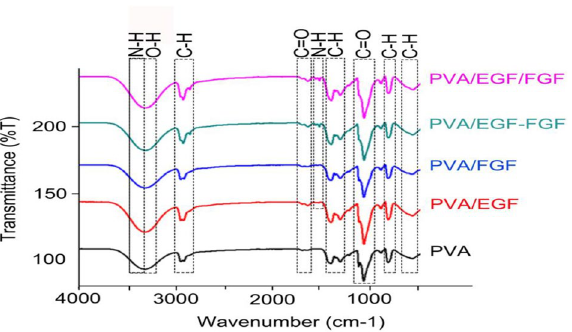
Figure 2. ATR-FTIR spectra of electrospun nanofibers: (a) PVA, (b) PVA/EGF, (c) PVA/FGF, (d) PVA/EGF- FGF and (e)